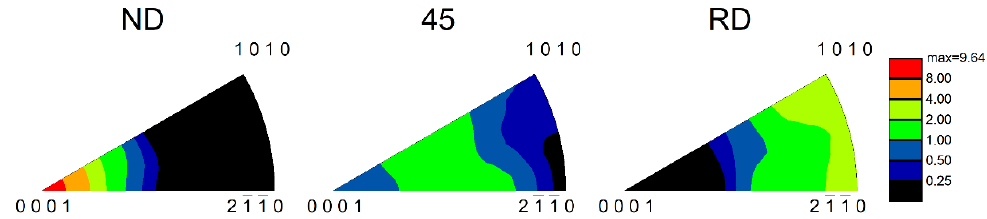
Figure 1. Inverse pole figure of samples cut in the ND, 45 ◦ between RD and ND, and RD directions. In order to discuss the active deformation mechanisms, SF for basal, prismatic, and 2nd order pyramidal slip, and {101̅2} extension and {101̅1} compression twinning were evaluated. The CRSS values had to be taken into account. The comparison of SF for given deformation mechanisms is as follows: basal slip ≅ {101̅2} twinning < prismatic slip << 2nd order pyramidal ≅ {101̅1} twinning [17]. This means that the other mechanisms were expected to be active only if the orientation was not containing more than 16,000 grains.